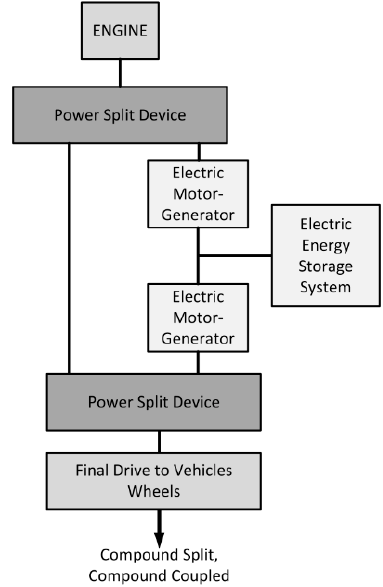
Figure 24. Compound split e-CVT system. Adapted from [32].